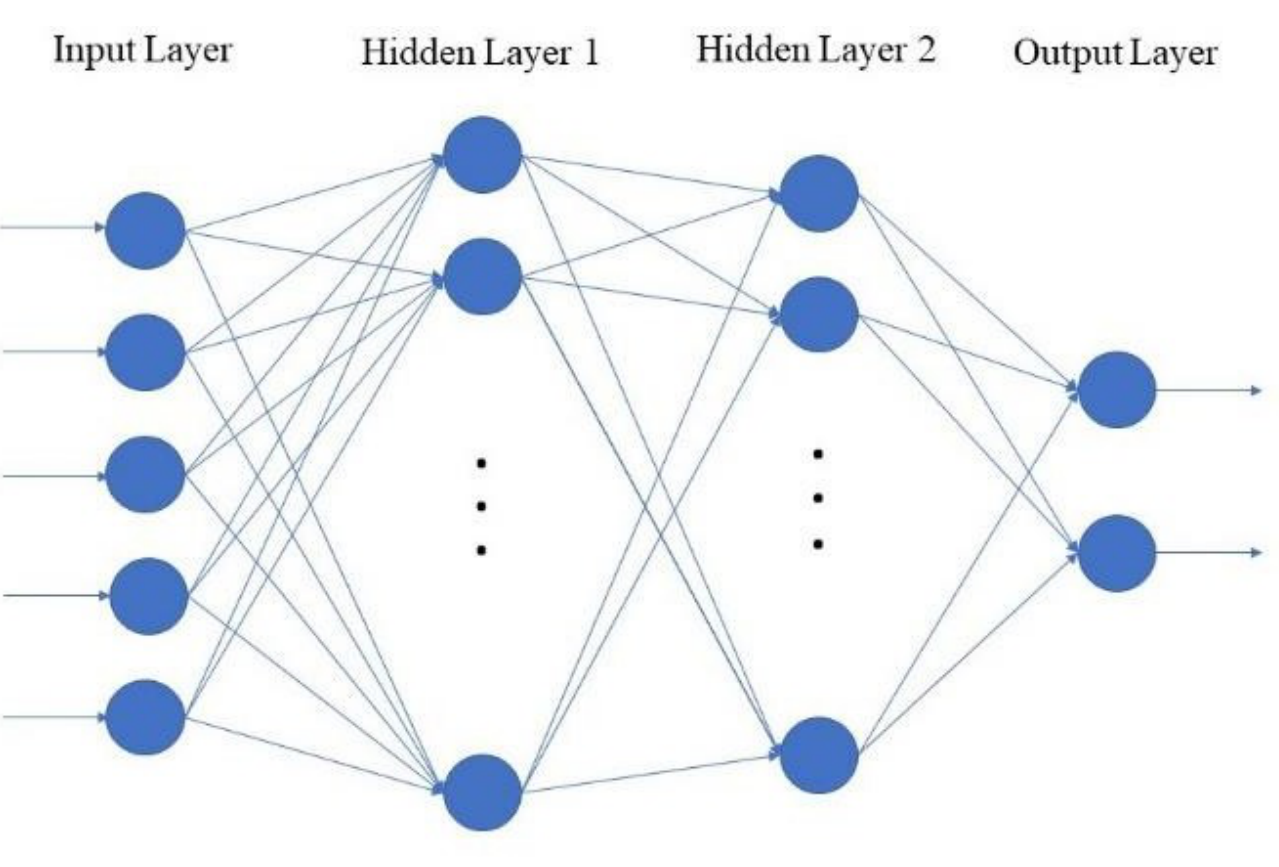
Figure 5. The neural network diagram of the proposed MLP model.